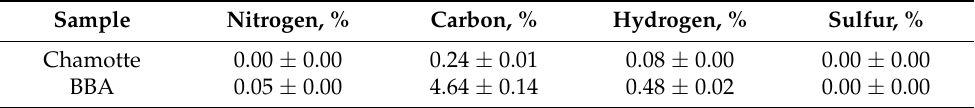
Table 2. Elemental analysis of the chamotte and the BBA.